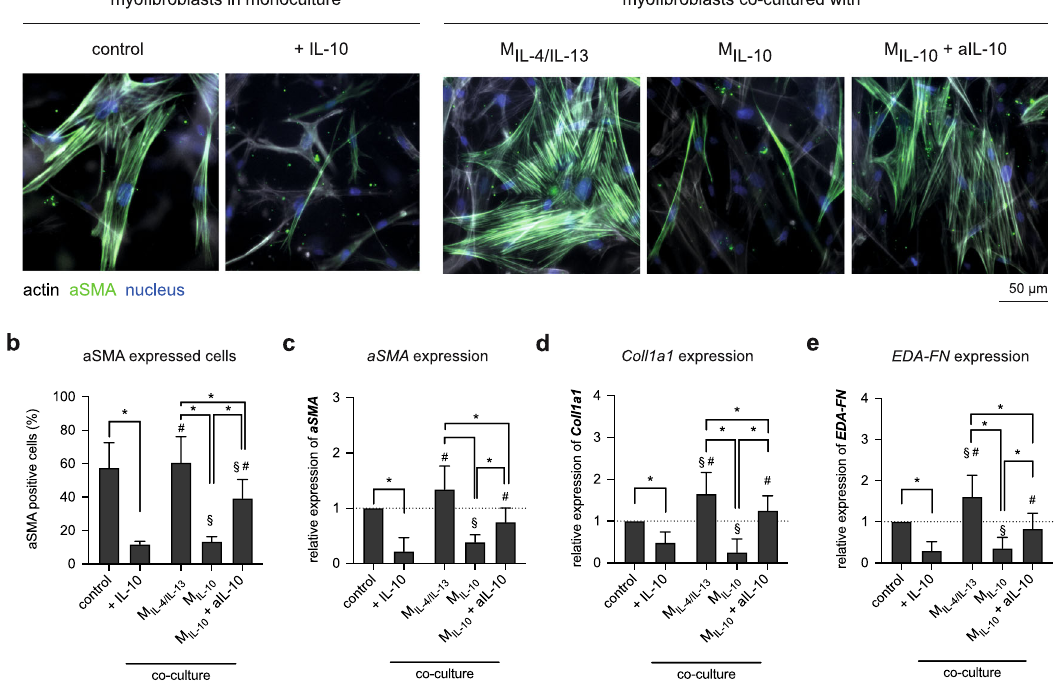
Fig. 6 Alteration of myo fi broblasts morphology and speci fi c markers in the presence of IL-10 and co-culture with M2 macrophages subtypes. a Representative images showing nuclei (blue), actin fi laments (gray), and α SMA (green) (scale bar: 50 μ m). Myo fi broblast de- dedifferentiation were analyzed using b percentage of α SMA-positive cells by manual counting of cells with α SMA incorporation into actin stress fi bers and quantitative analysis of c α SMA , d Coll1a1 , and e EDA-FN gene expression. For quantitative analysis of α SMA-positive cells, at least 200 cells per condition were counted. Data are represented as mean ± SD; *signi fi cance level of p ≤ 0.05 using a one-way ANOVA followed by Tukey ’ s post hoc analysis). The characters # and § represent the signi fi cance level of p ≤ 0.05 using a one-way ANOVA followed by Tukey ’ s post hoc analysis when compared to control, and treated samples with IL-10, respectively. Experiments were performed in four